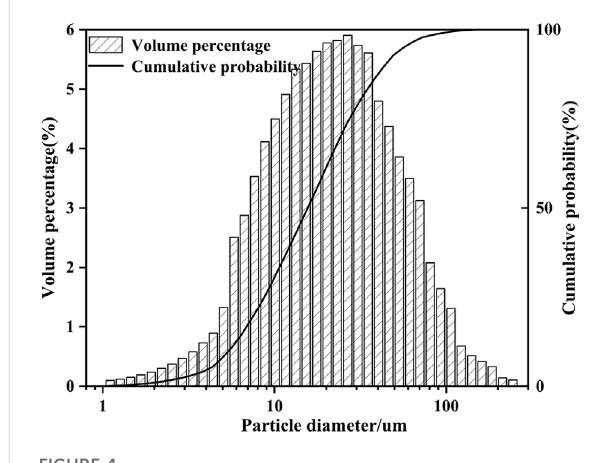
FIGURE 4 Distribution diagram of carbon particle diameters.